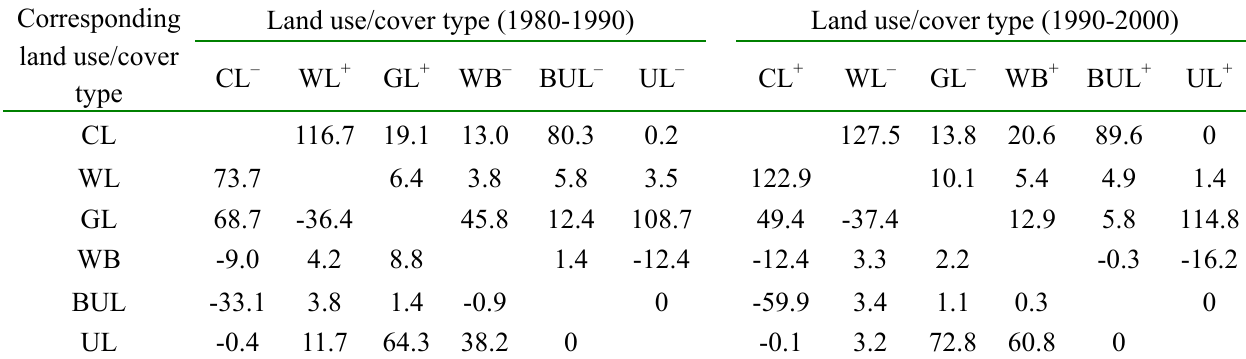
Table 3 . The percentages taken by corresponding types in internal conversions among land use types.